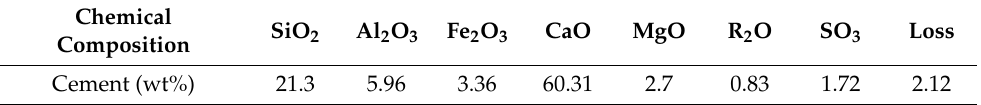
Table 2. Chemical composition of